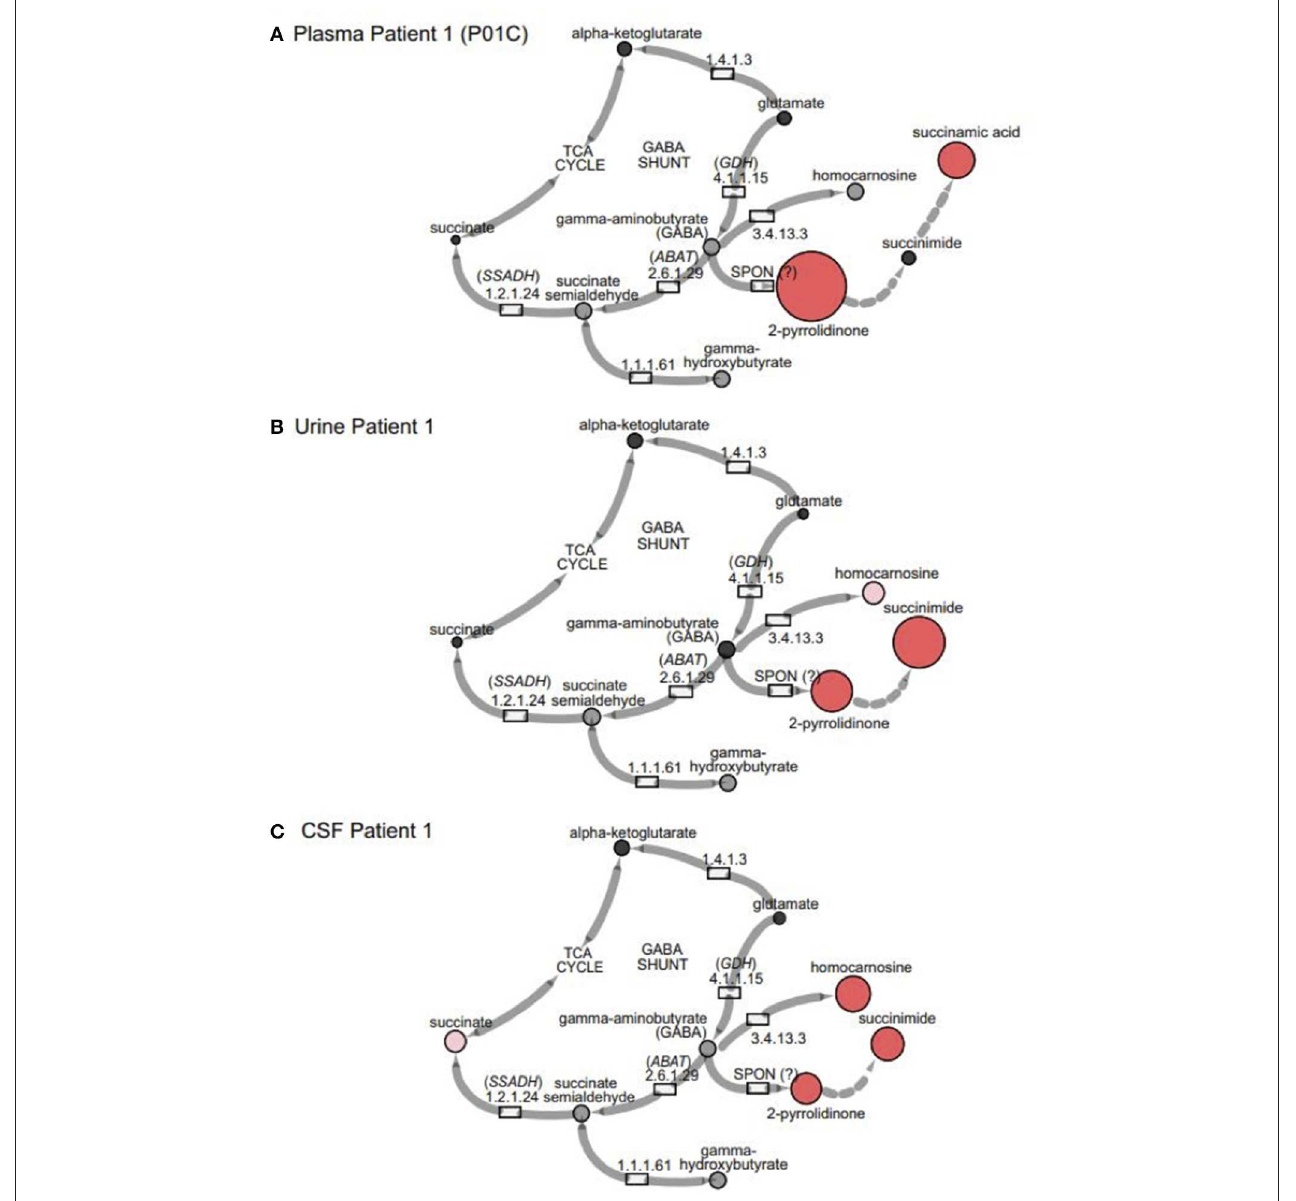
FIGURE 3 | GABA metabolites are altered in GABA-transaminase deficiency and in use of treatments affecting GABA metabolism. Representative pathway images are shown for GABA-transaminase deficiency Patient 1 in (A) EDTA Plasma, (B) Urine, and (C) CSF. Each image shows the relative accumulation of biochemicals (red circles) or trending increases (pink circles, 1.5 ≤ Z < 2). The size of each of the circles is representative of the Z -score for that biochemical. Black circles represent molecules with Z -scores between − 1.5 and 1.5 ( − 1.5 < Z < 1.5) or detected rare molecules for which a Z -score could not be calculated. Gray circles represent biochemicals in the library but not detected in the samples using Cytoscape to delineate biochemical pathways (http://cytoscape.org) (Shannon et al., 2003). All enzymes in the pathway are denoted by their EC designations. GDH , glutamate dehydrogenase; SSADH , succinic semialdehyde dehydrogenase; ABAT , aminobutyrate aminotransferase; SPON,